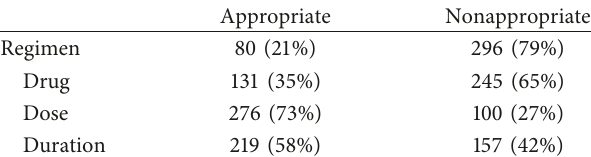
Table 2: Appropriateness of treatment.